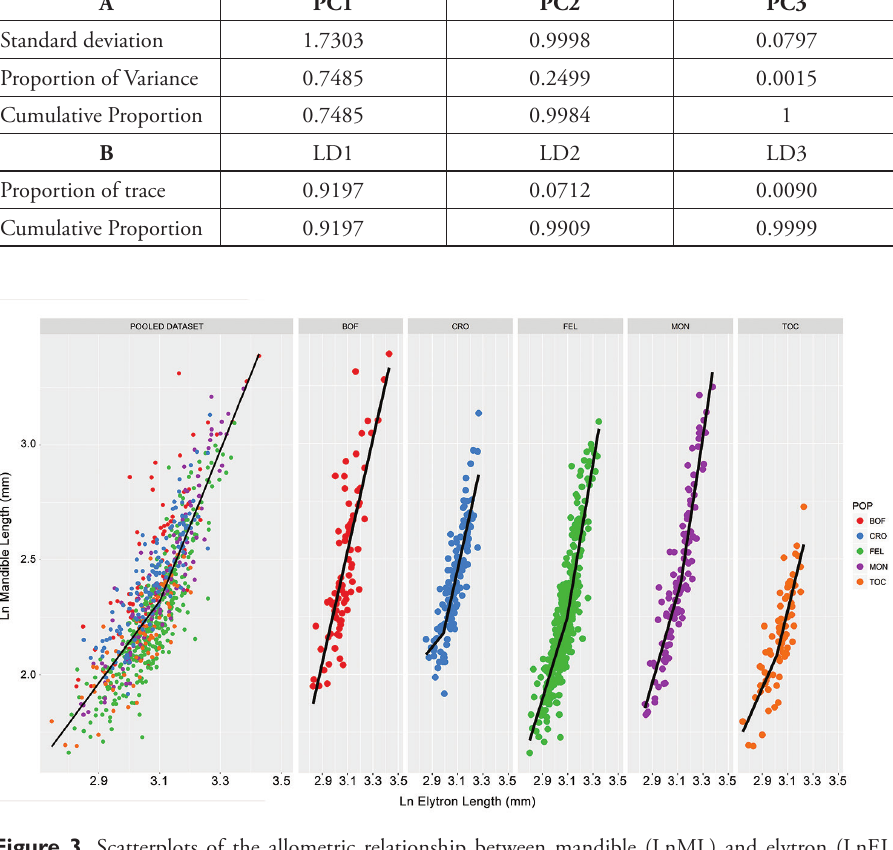
Figure 3. Scatterplots of the allometric relationship between mandible (LnML) and elytron (LnEL) length, with the top ranked model superimposed on the basis of its AIC score. The pooled dataset il- lustrates the trend of the scaling relationship for all the analysed populations. The allometric trajectory of each population was reported in subsequent